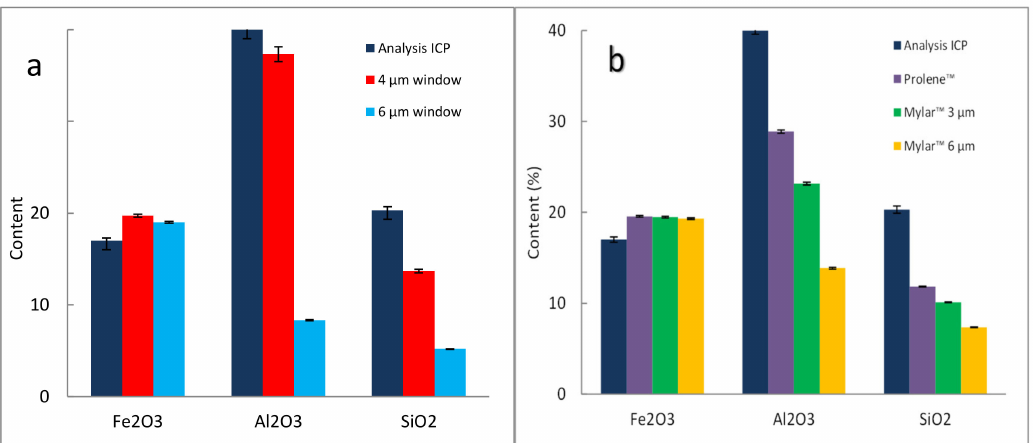
Figure 9. ( a ) Fe, Al, and Si concentrations when measured through different membranes, compared to the laboratory values and ( b ) Fe, Al, and Si concentrations when measured through different films, compared to the laboratory values. Certified values: iron oxide 17.0%; Aluminium oxide 40.0%; Silicon dioxide 20.3%. Measurements with a Niton XL3t980 spectrometer on a bauxite standard sample (NIST 600).